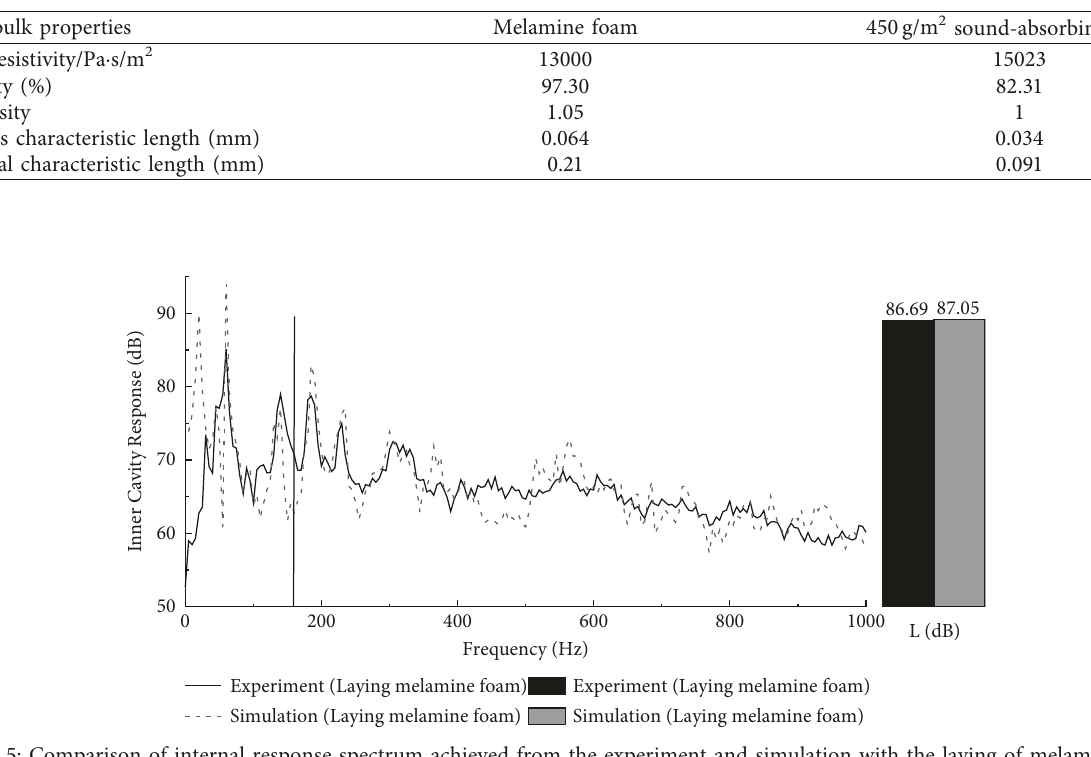
Figure 4: Comparison of internal response spectrum achieved from experiment and simulation before the laying of the material. Table 3: Fluid bulk properties of porous